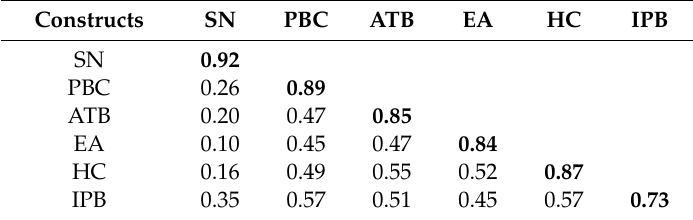
Table 4. Constructs’ correlations and square roots of average variance